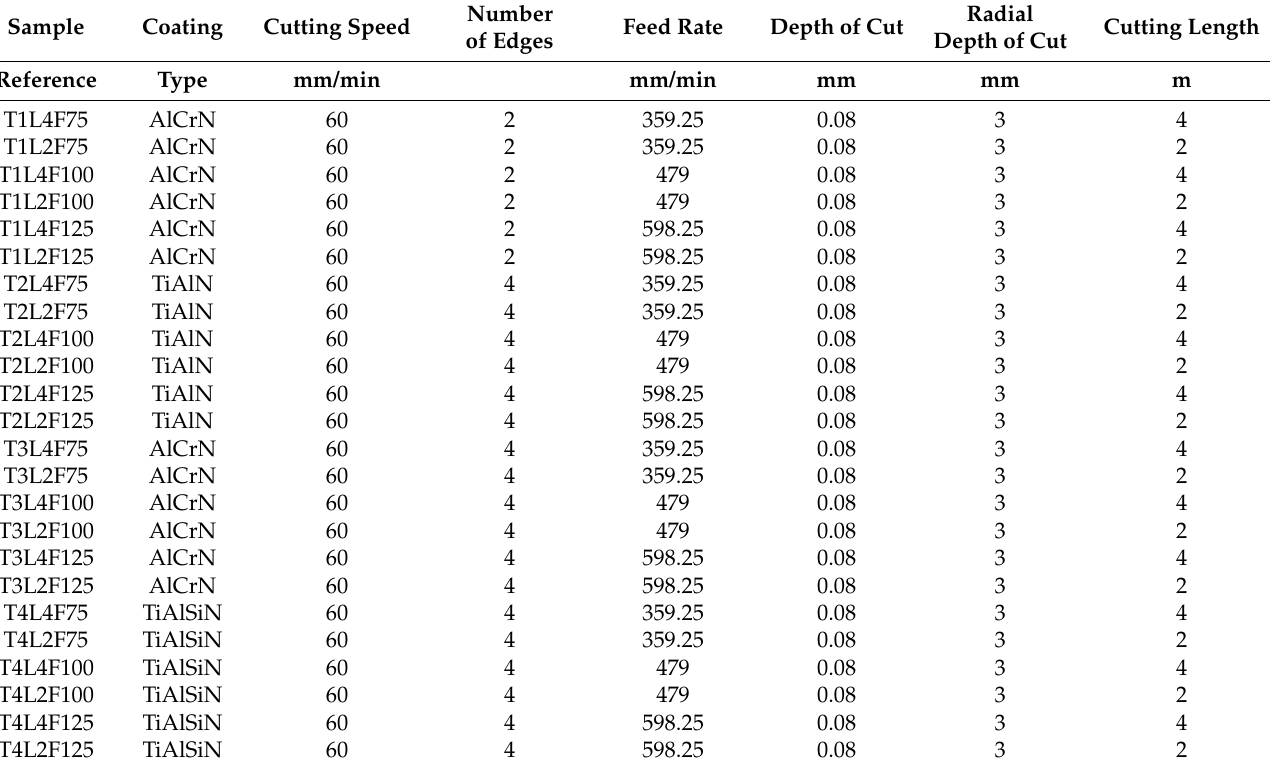
Table 4. Parameters used in the machining